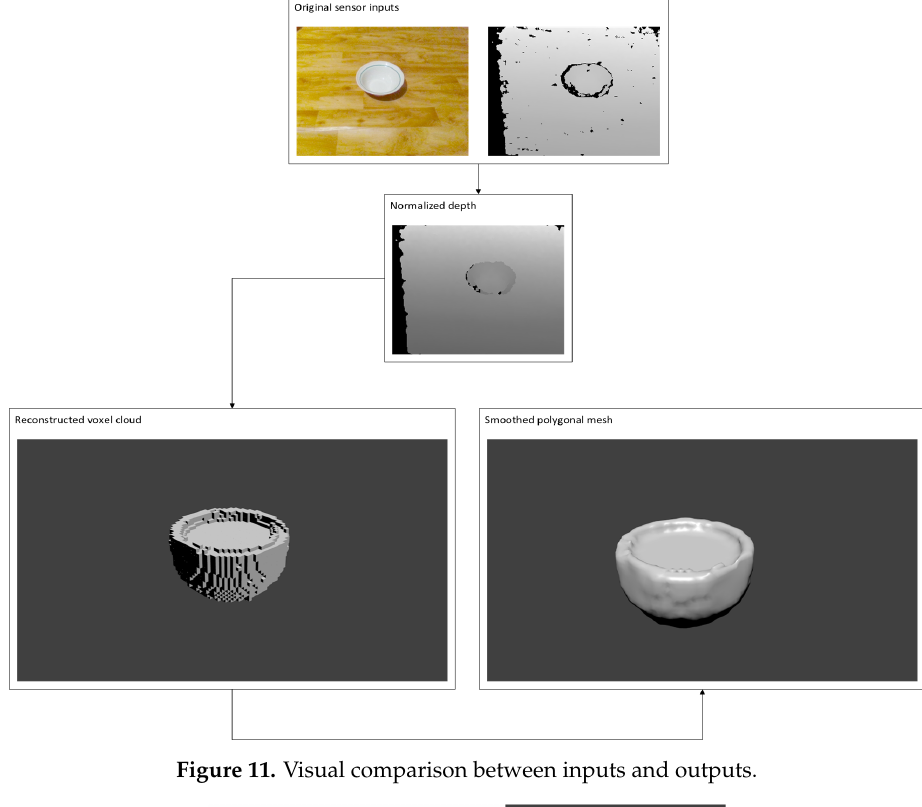
Figure 11. Visual comparison between inputs and outputs.